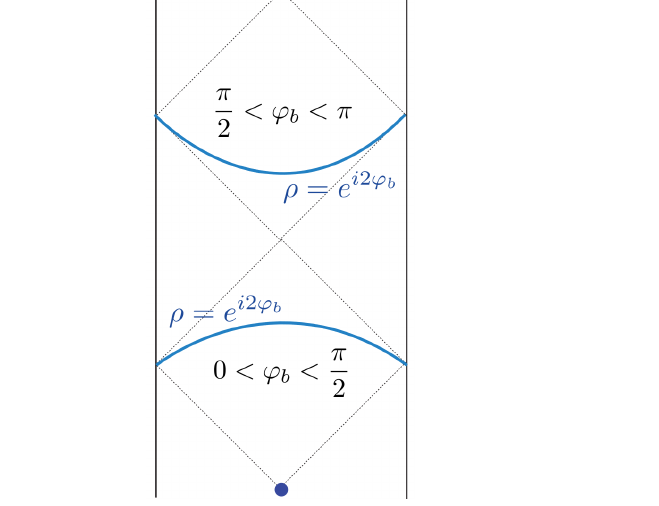
Figure 8. An illustration of two example return loci for branes of different tension/causal depth. When the brane tension is positive, ϕ is greater than π/ 2 and null geodesics return to the boundary b along a curve in the upper causal diamond. When the brane tension is negative, ϕ is less than π/ 2 b and null geodesics return to the boundary along a curve in the lower causal